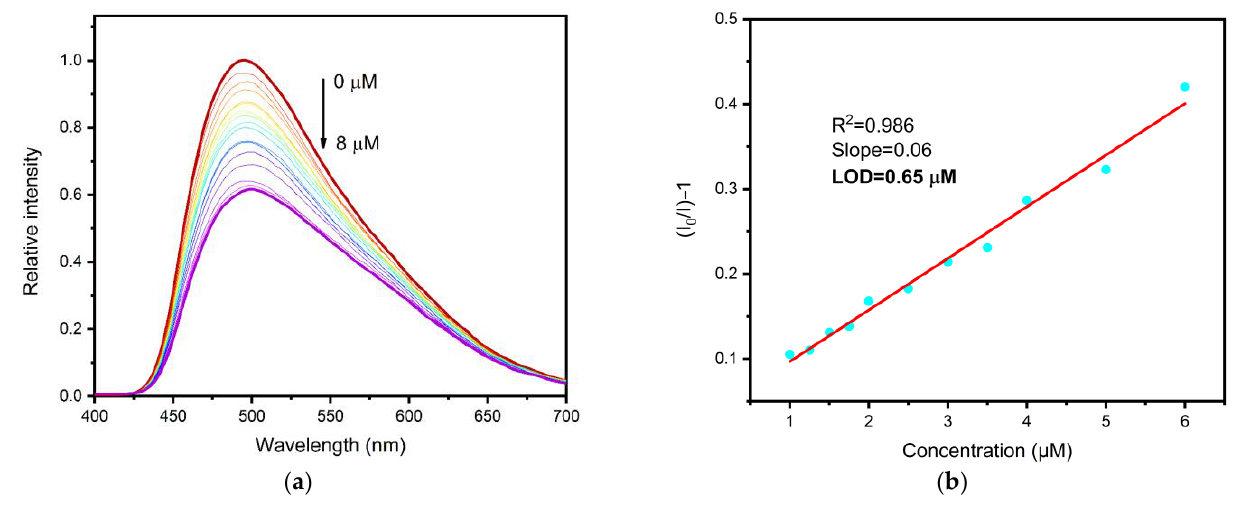
Figure 6. Fluorometric titration of gossypol: ( a ) emission spectra of MOF 1 ethanol suspension at 310 nm excitation and different amounts of gossypol added; ( b ) Linear approximation of luminescence quenching for LOD calculation. The relative luminescence quenching values were calculated from the integral intensities. Table 2. Detection limits for other reported gossypol-sensitive